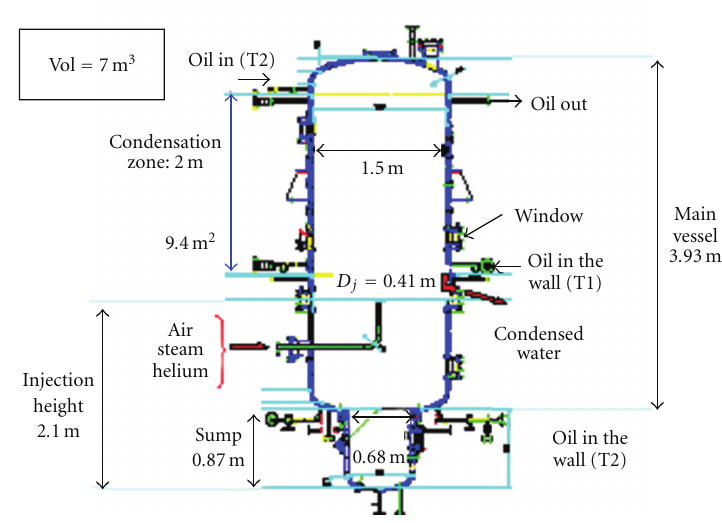
Figure 1: Precise geometry of TOSQAN